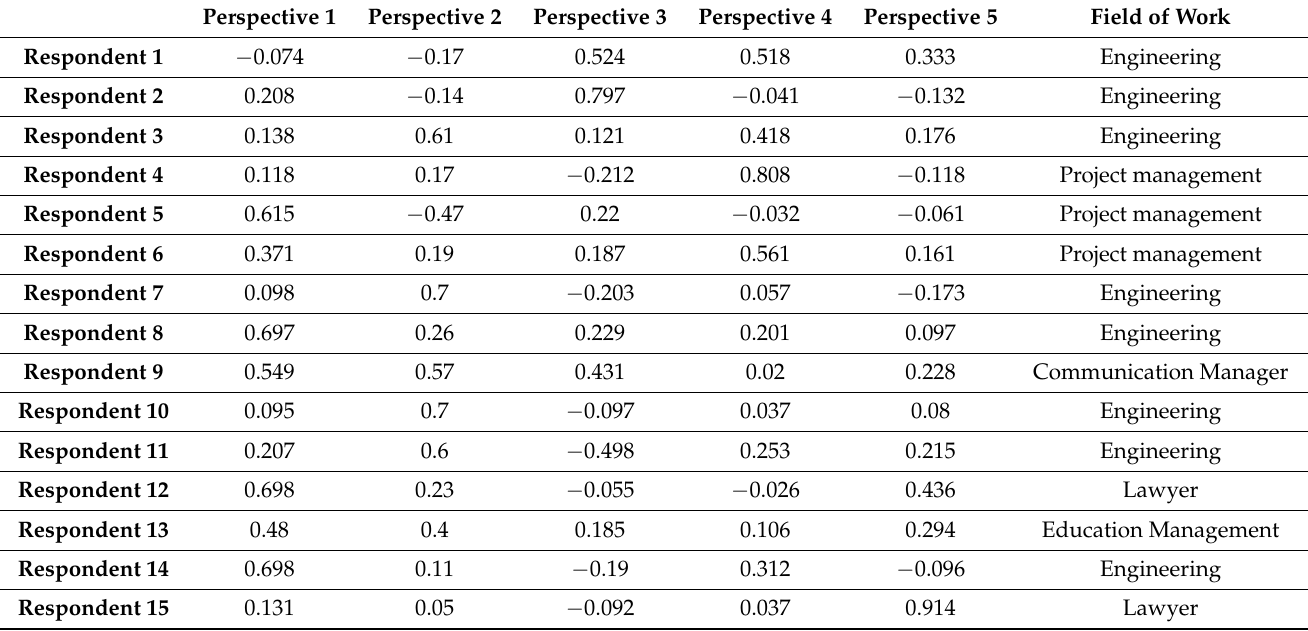
Table 5. Perspective matrix. Highest scores for each respondent have been shadowed in